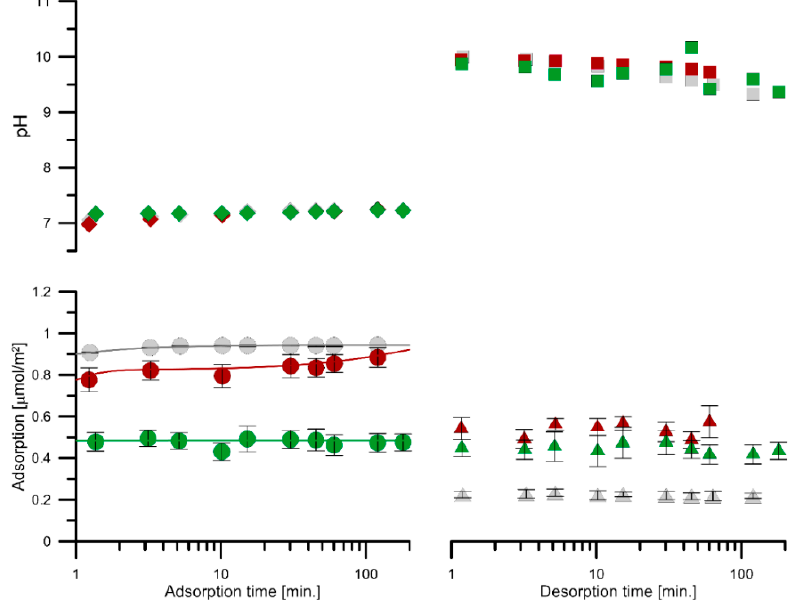
Figure 1. Kinetics of pH changes of suspension and carboxylic ion adsorption / desorption changes on hydroxyapatite from the carboxylic ion solution of the initial concentration 0.000001 mol / dm 3 . Grey points denote the oxalic, green points denote citric, and ruby points denote tartrate ions. The black, green, and wine colored lines represent a fit with a pseudo-second-order kinetic equation for the adsorption kinetics of oxalate and citrate anions and multiexponential equation for tartrate anions, respectively. The parameters of adsorption fitting line are presented in Tables 1 and 2.